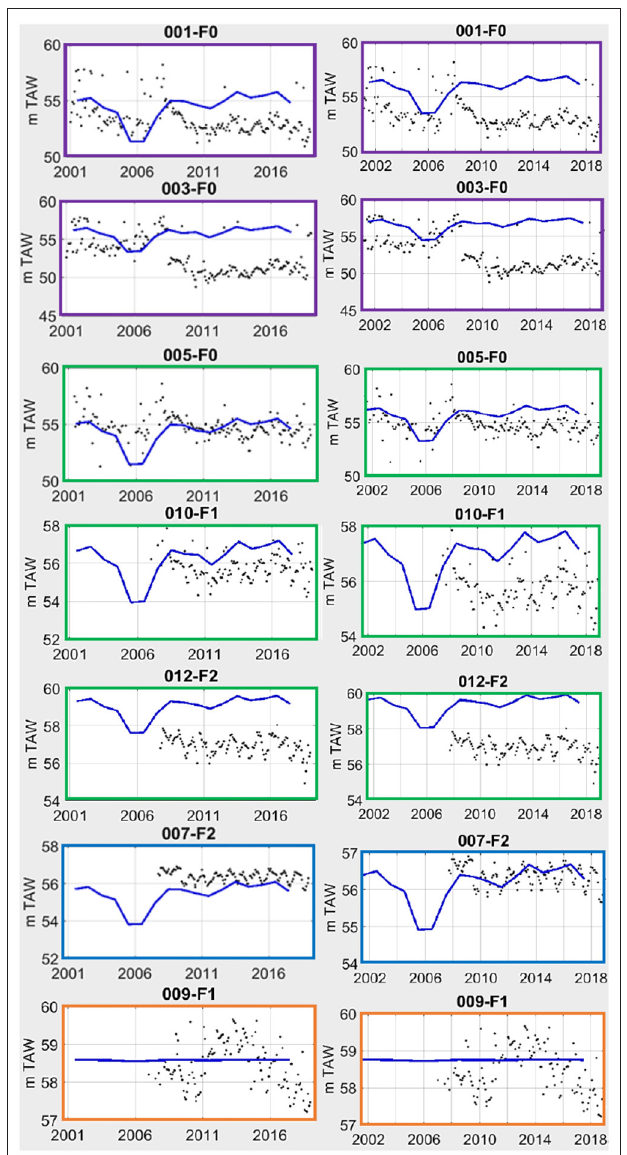
FIGURE 8 | Calibration results for the homogeneous case (left) and scenario E3 (right). The dots show the monthly hydraulic head measurements, the blue line is the simulated yearly hydraulic head. Explanation of color frames: purple, pumping well; green, formation of Maastricht; blue, Member of Orp; orange,